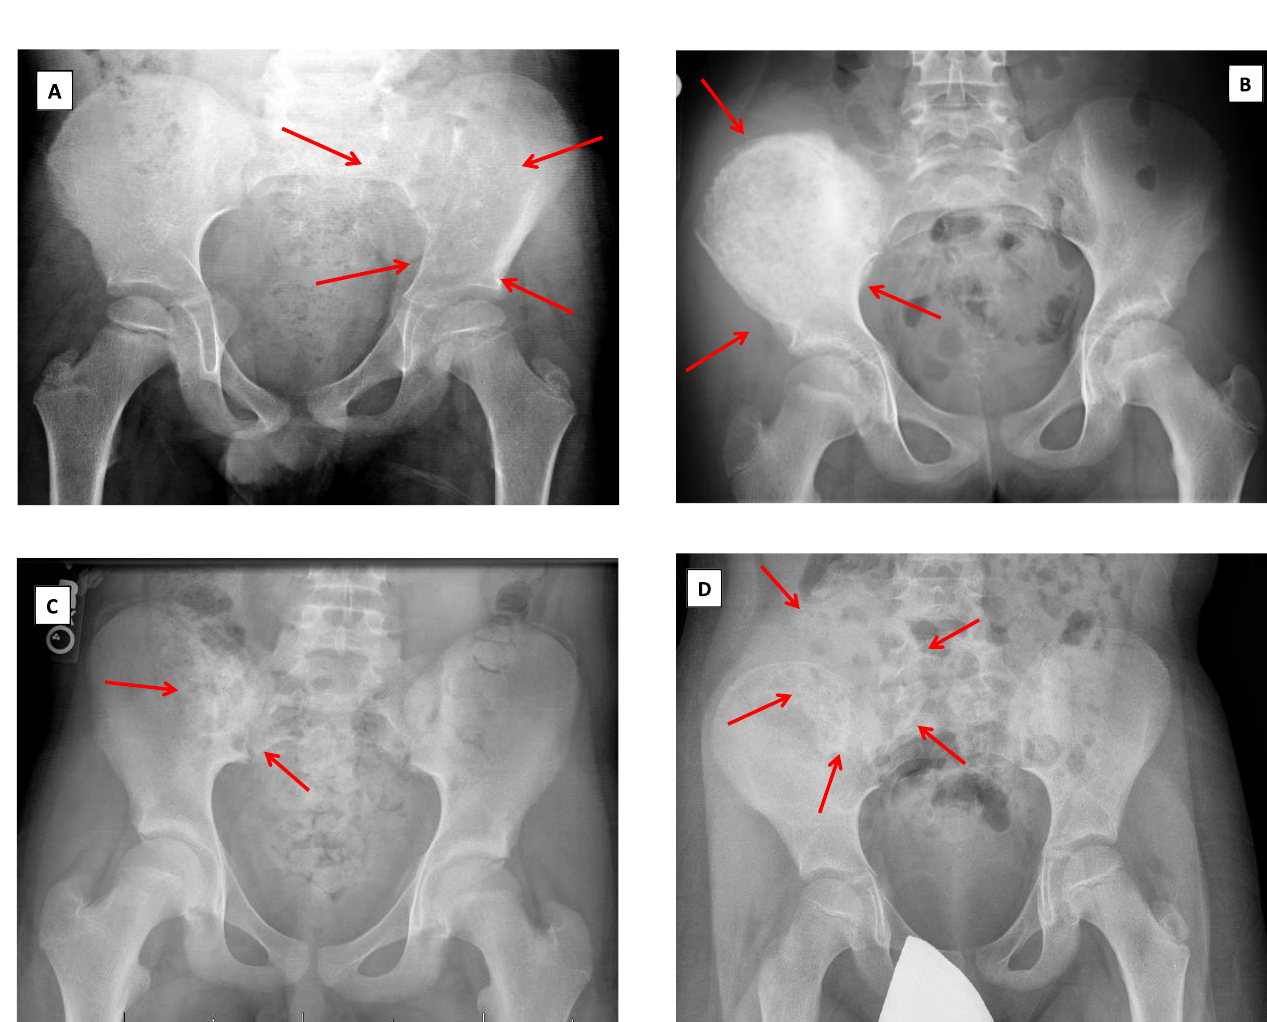
Figure 3. Radiographic presentation of pelvic sarcoma. Lytic lesion in 6.7-year-old male with Ewing sarcoma in the left ilium (A), calci fi c lesion in a 12 years old female with Ewing sarcoma in the right ilium (B), mixed lesion in a 14 years old male with Ewing sarcoma in the right ilium (C), and soft tissue mass without boney lesion in a 7 years old male with Ewing sarcoma